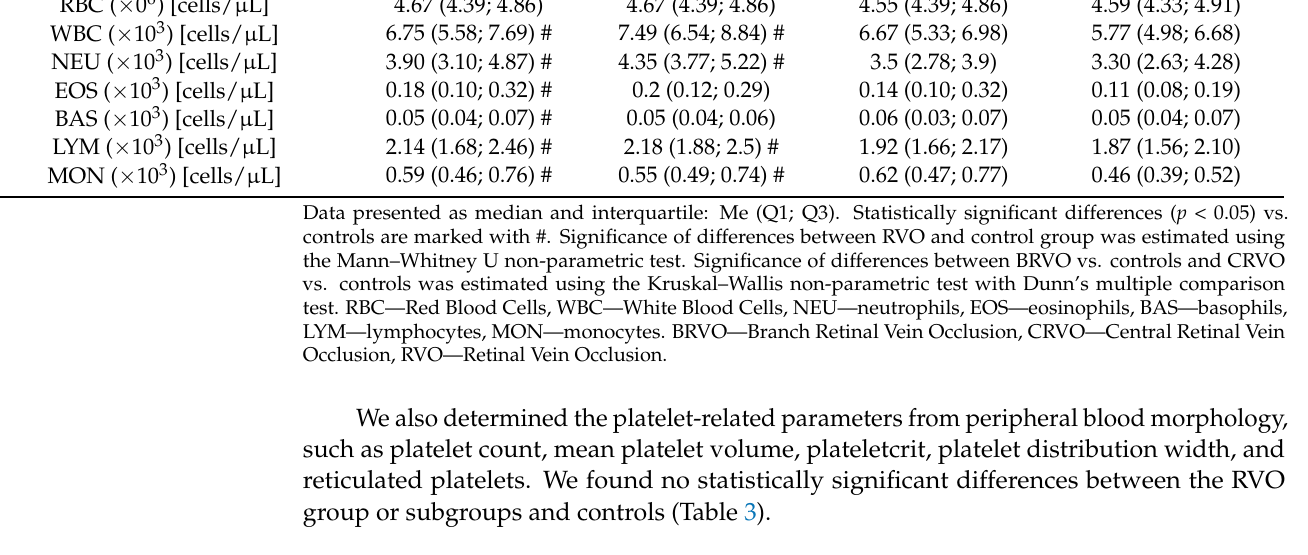
Table 3. Platelet indices calculated from peripheral blood morphology in RVO patients and controls.